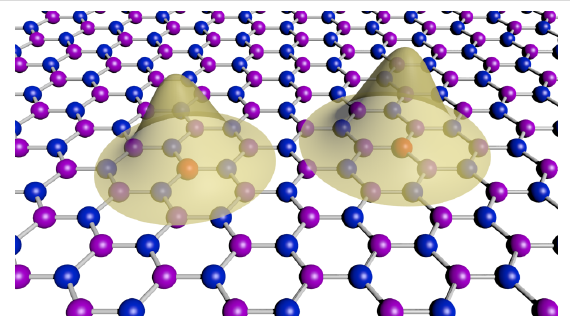
Figure 1: Schematic representation of the electronic distributions around two donors (represented in red) in a 2D material. Many of the 2D materials currently under study have a graphene-like crystal struc- ture (two sublattices represented by blue and violet dots). Here we explore, within an effective mass approach, the possibility of using these donors to implement spin-qubits. Some of those 2D structures may present advantages over bulk (3D) semiconductor